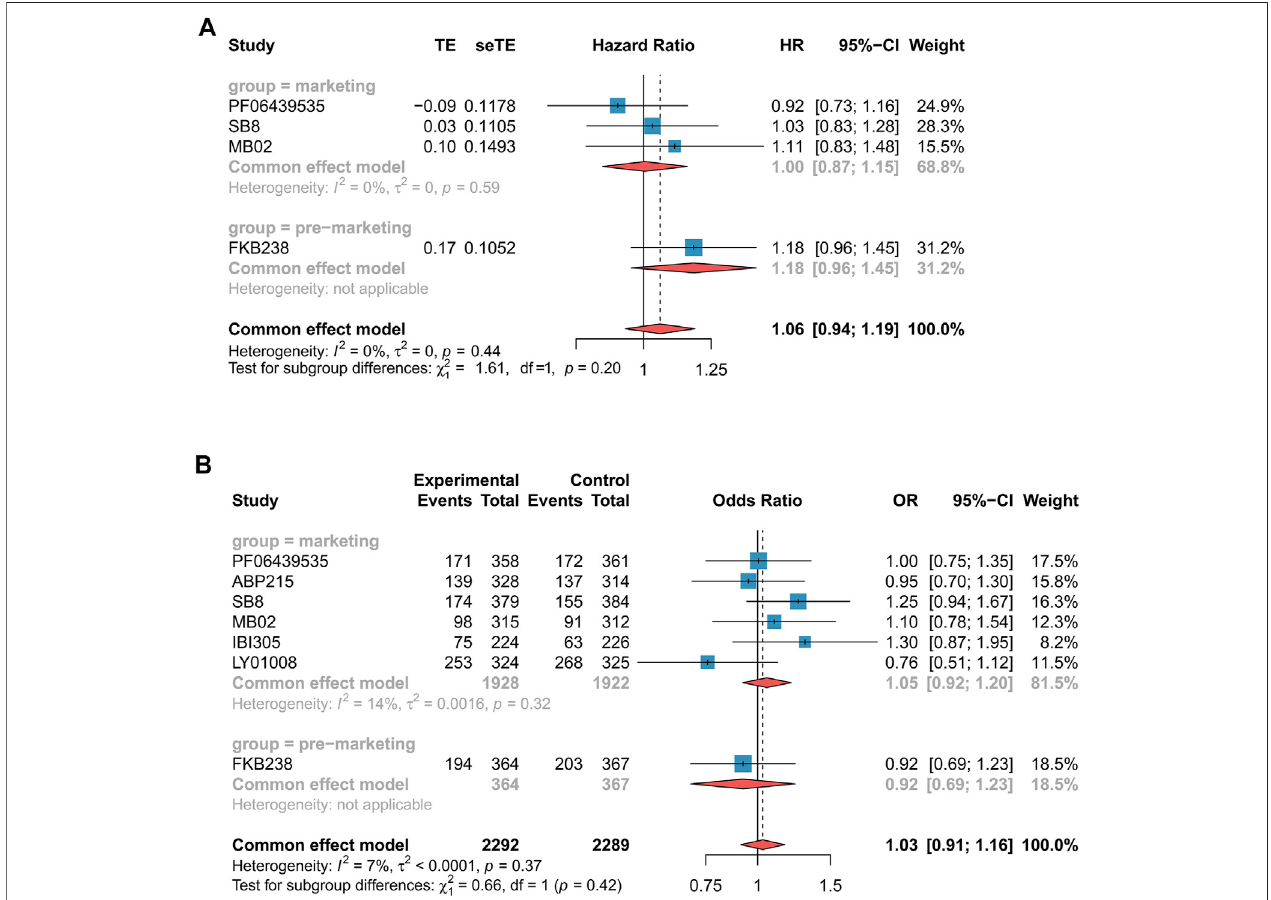
FIGURE3| Forest plotsofoverallsurvivaland incidence rateofgrade3 – 5adverse eventsfornon-smallcelllung cancerpatients. (A) Overallsurvival. (B) Incidence ofgrade 3 – 5adverse events. Thesedrugs weregroupedbymarketing.Themarketing drugincluded PF-06439535, ABP215,SB8, MB02,IBI305,and LY01008, while FKB238 belonged to the premarketing drug. Overall survival and incidence of grade 3 – 5 adverse events were measured using hazard ratio (HR) and odds ratio (OR), respectively.IftheHRvaluewasmorethan1,itfavoredthebiosimilargroup;otherwise,itfavoredthereferencegroup.IftheORvalueishigherthan1,itfavoredthe reference biologics group; by contrast, it favored the biosimilars group. CI, con fi dence interval; OR, odds ratio; and HR, hazard ratio.